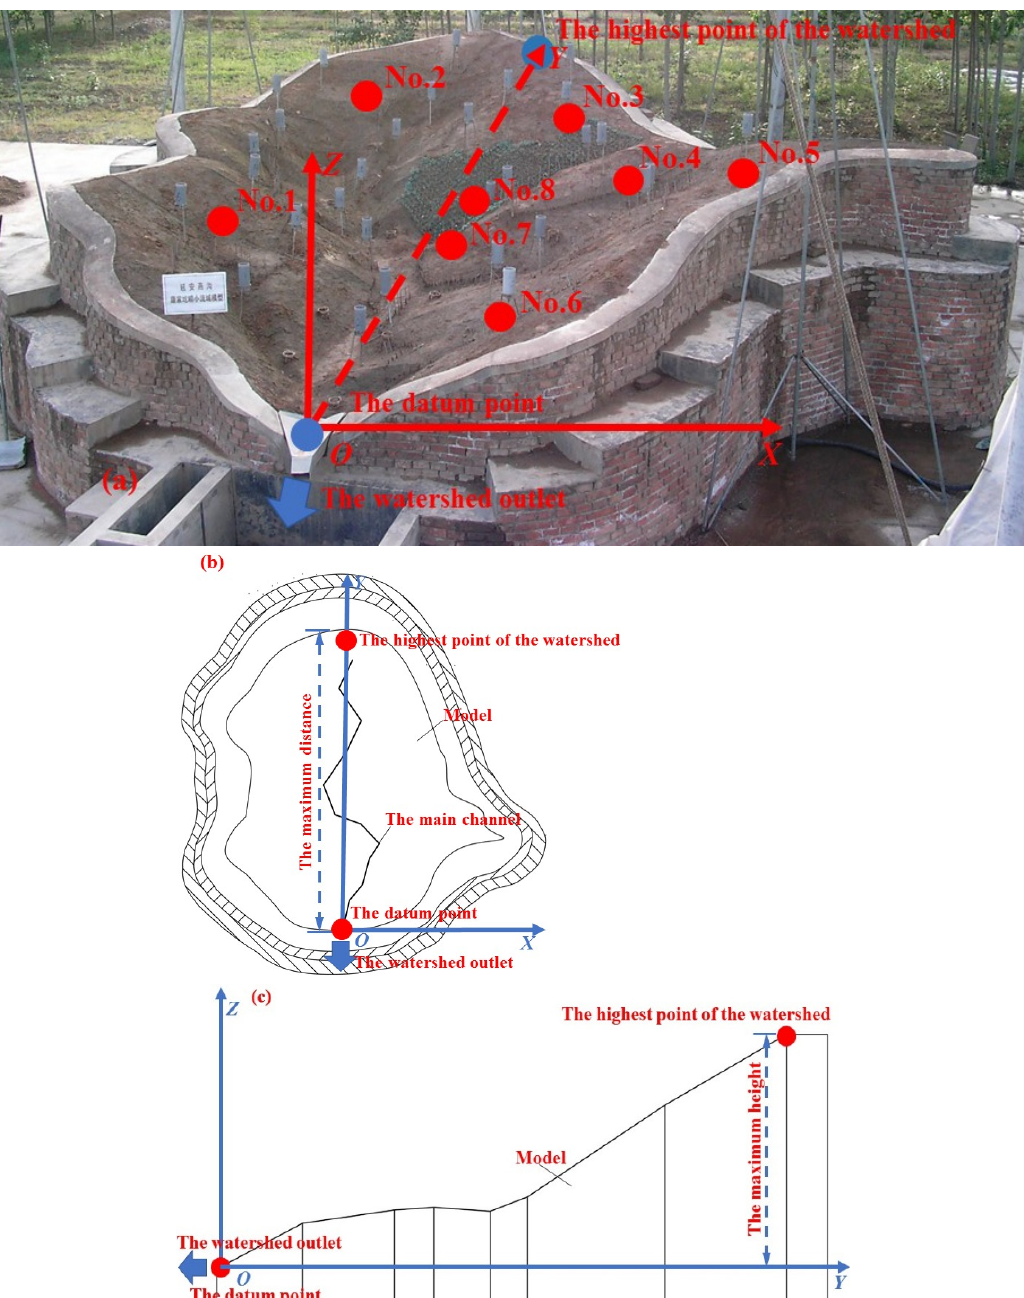
Figure 2. The model built according to the two situations; ( a ) no vegetation restoration, ( b ) longitudinal diagram of experimental design, ( c ) sectional drawing of experimental design.